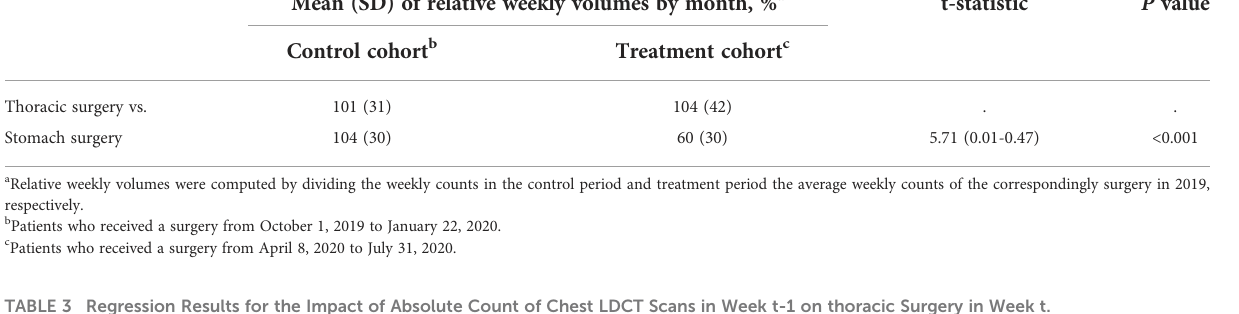
TABLE 3 Regression Results for the Impact of Absolute Count of Chest LDCT Scans in Week t-1 on thoracic Surgery in Week